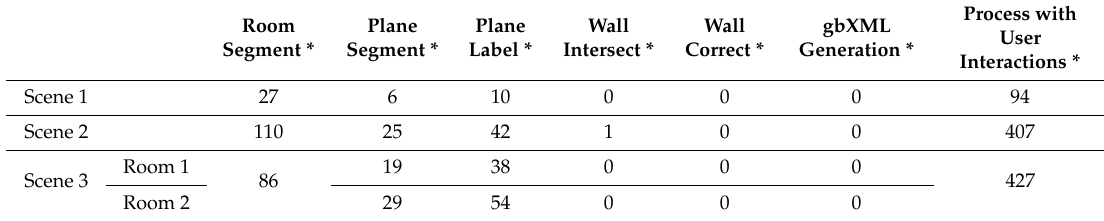
Table 3. Summary of the performance of the software system (* all values are in seconds).